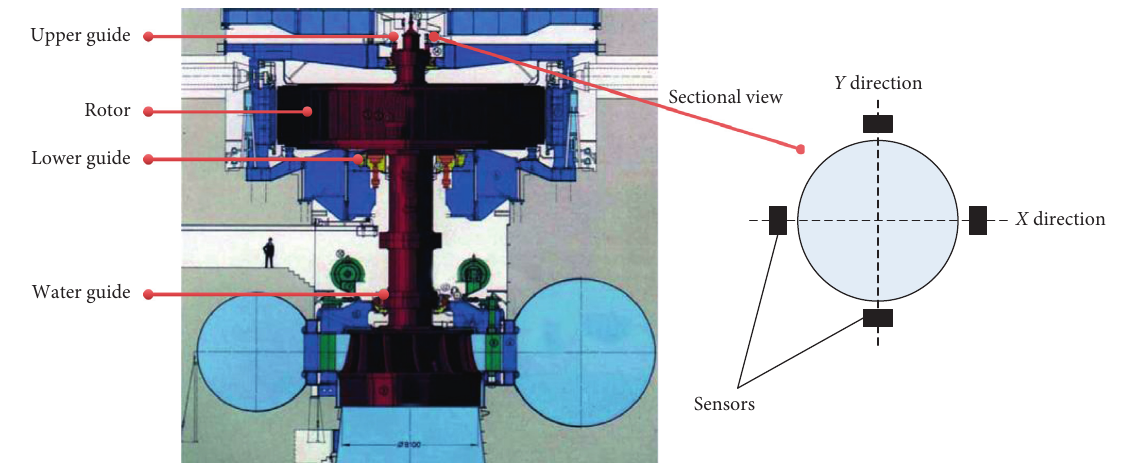
Figure 6: The structure of HGU and the corresponding monitoring location of